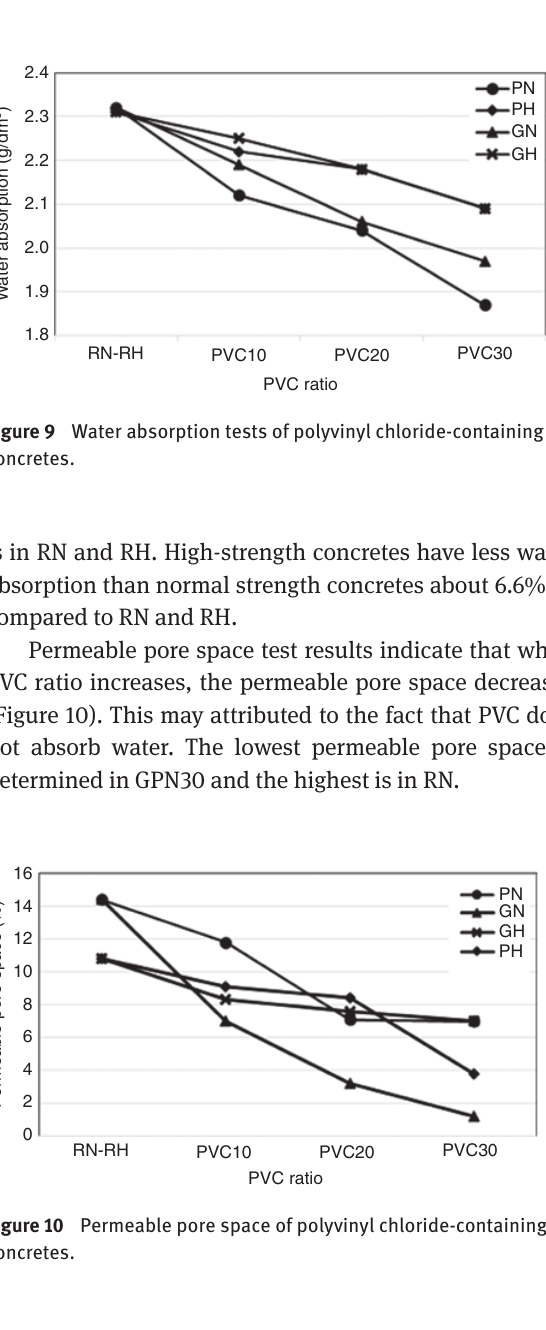
Figure 8 Saturated density tests of polyvinyl chloride-containing concretes.